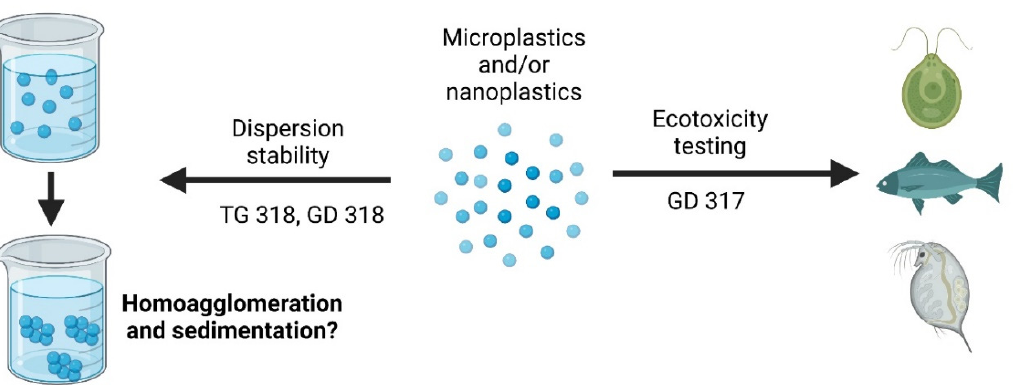
Figure 2. Schematic showing the potential use of GD 317 and 318 and TG 318 with nanoplastics or microplastics. Produced using biorender.org.